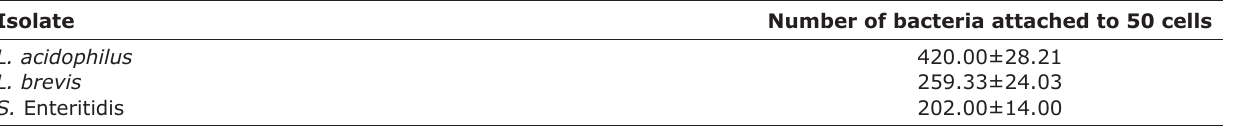
Table-6: Ability of L. acidophilus , L. brevis , and S. Enteritidis to adhere to 50 cells.